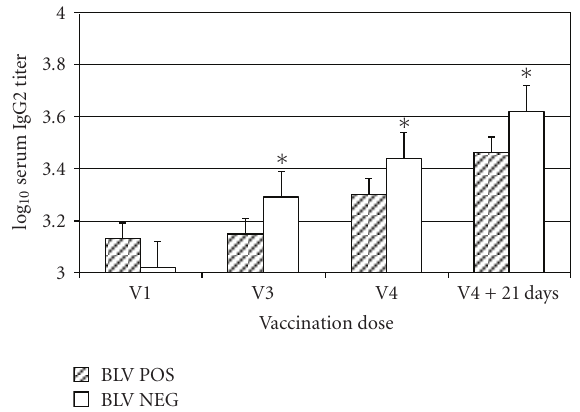
V4 + 21daysV4V3V1